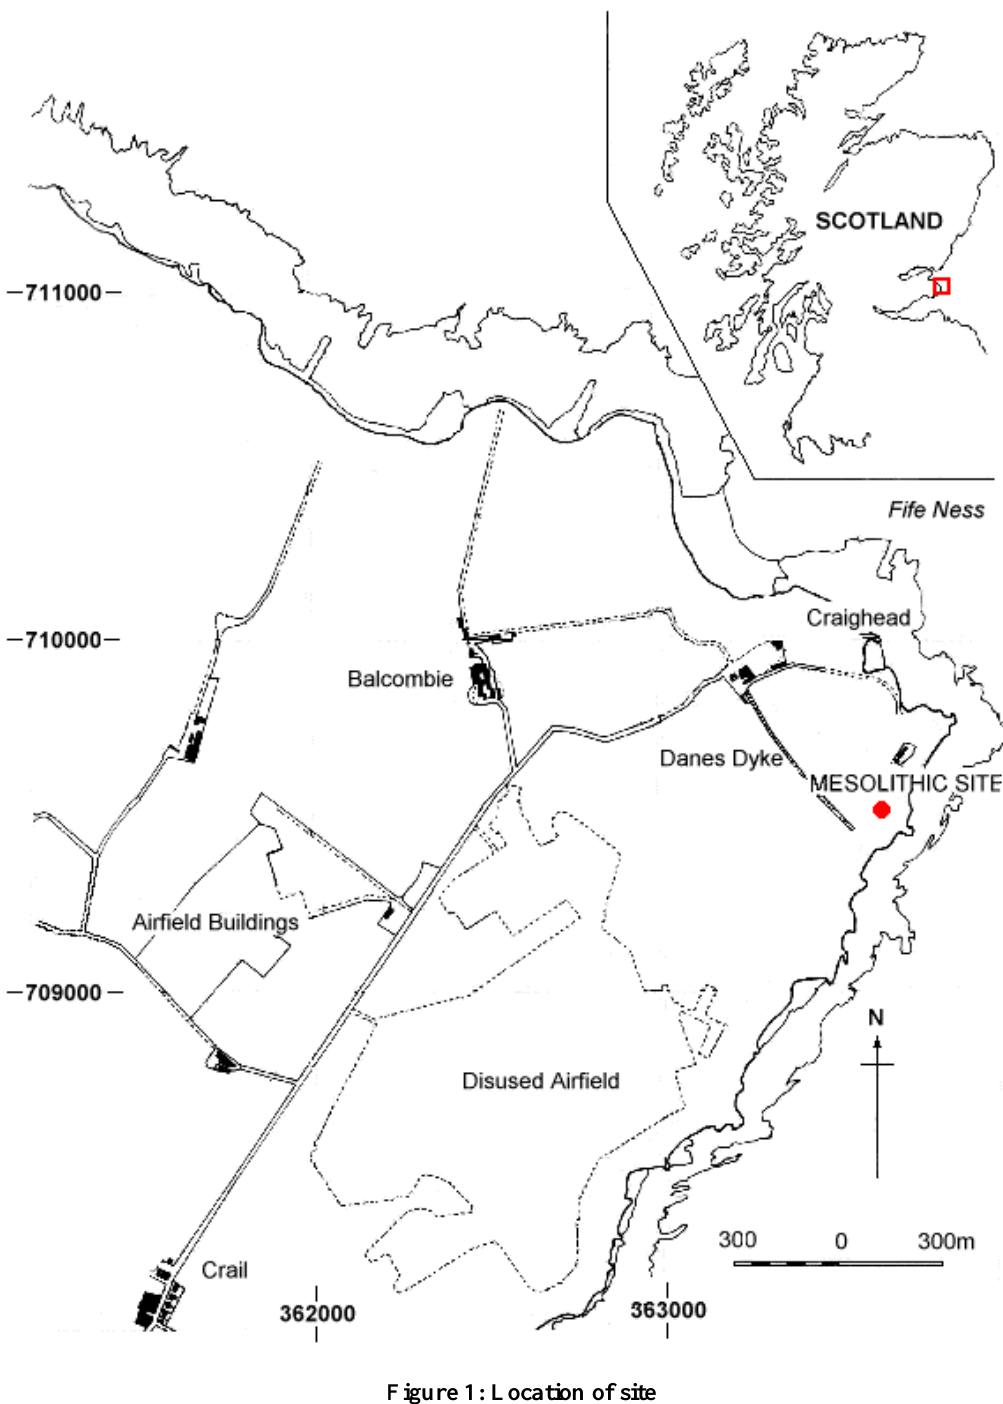
Figure 1: Location of